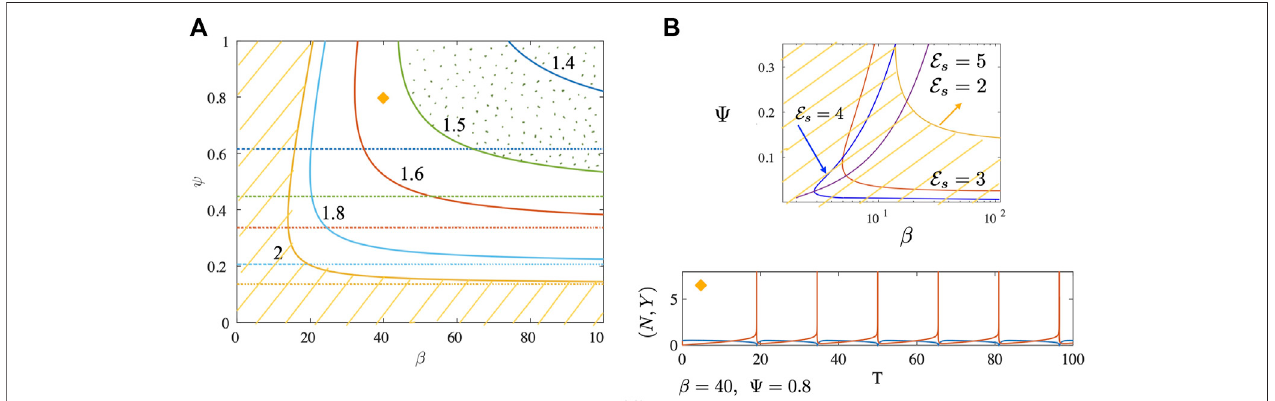
FIGURE 3 | (A) Neutral stability curves separating linearly stable from unstable regions are shown for the no drag case. Plotted as solid curves are results for different values of E s (as indicated, from 1.4 – 2). The dash-dot lines are the limiting values of Ψ below which the base state is always stable. The shaded yellow region indicates thestable regionfor Ψ =2.Thedottedgreenregionindicates linearlyunstablespacesusceptible tooscillatory instabilitiesfor Ψ =1.5. The yellow rhombus point indicated in (A) is unstable for some parameter values, as demonstrated by full non-linear solutions when Ψ =2 (shown alongside). (B) For even larger values of E > 2, the curves shift rightward as Ψ increases. In all these cases, F ( E s